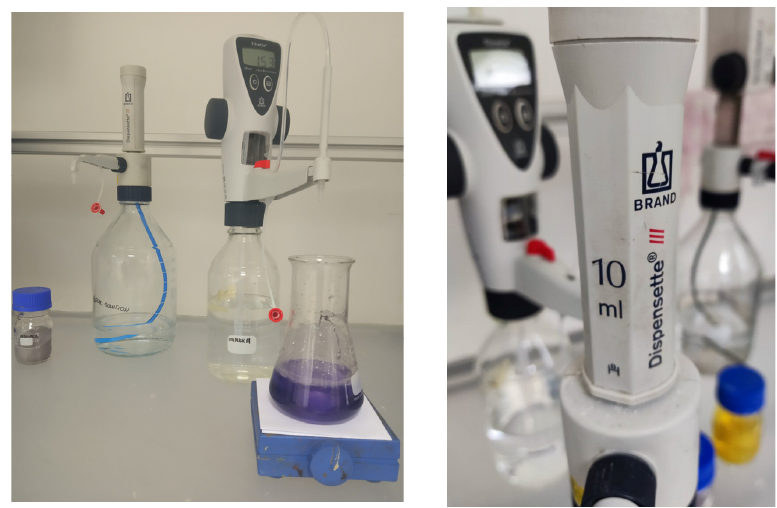
Figure 5. Pictures of titration equipment, EDTA method setup.